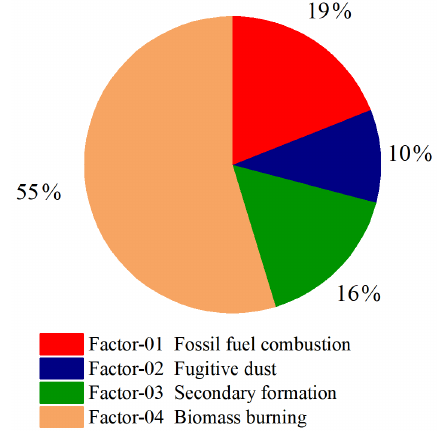
Figure 8. Source apportionment for airborne fine particulate BrC in Xi’an during the